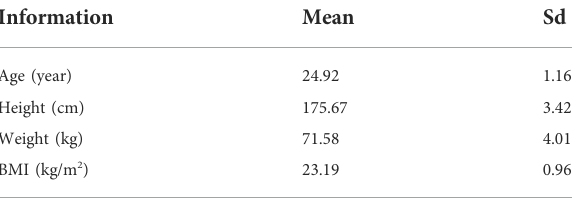
TABLE 1 Descriptive characteristics of 12 participants.